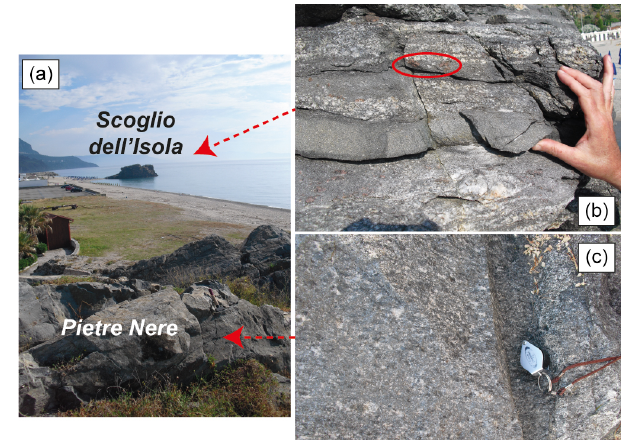
Figure 2. Photographs of (a) Scoglio dell’Isola and Pietre Nere outcrops, (b) fine-grained amphibolite layers within the migmatitic paragneiss locally containing centimeter-sized garnet grains (red circle), and (c) foliated domains in the Pietre Nere